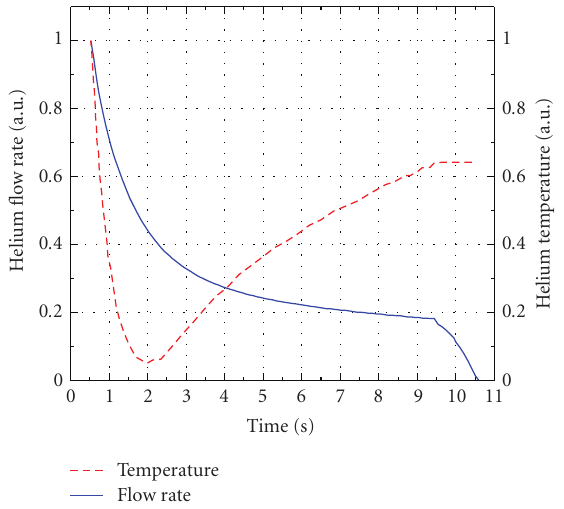
Figure 2: Evolution of helium flow rate and temperature escaping from primary circuit breach in the LB accident.